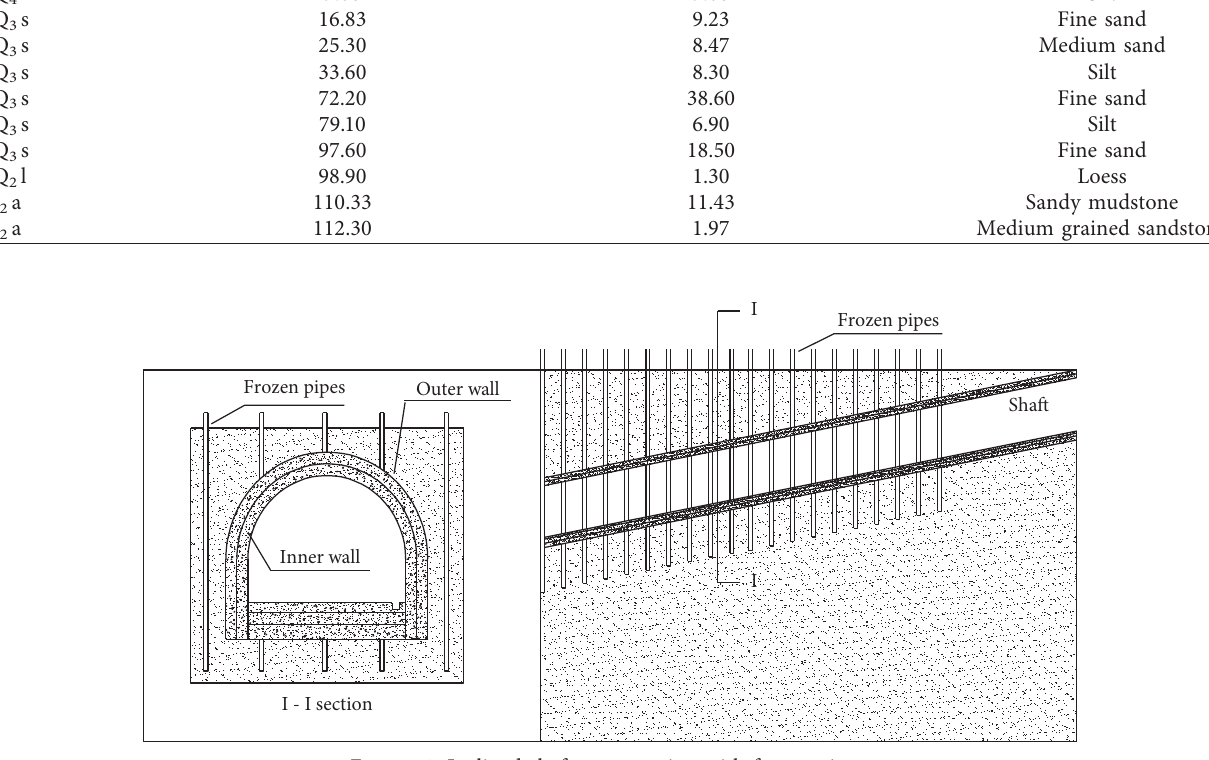
Figure 1: Inclined shaft cross section with frozen pipes.